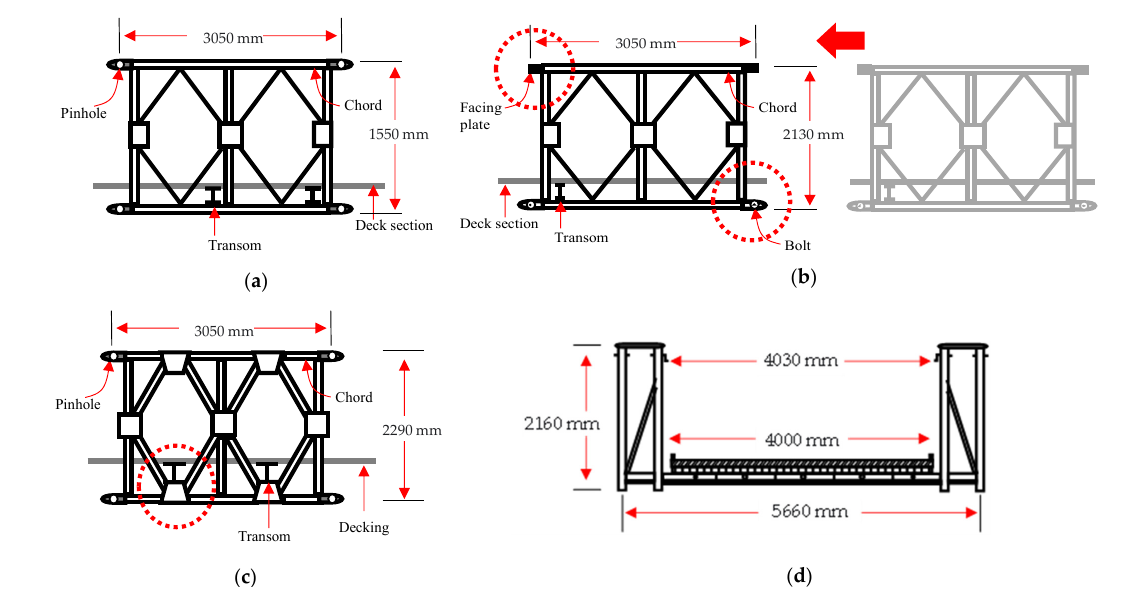
Figure 1. ( a ) Typical Bailey Bridge, ( b ) Mabey Bailey Bridge, ( c ) Acrow Bailey Bridge and ( d ) M2 typical end shear/post.